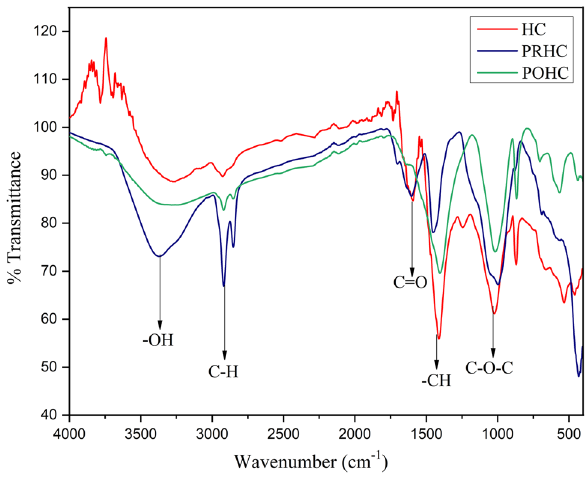
Figure 6. FTIR spectra of hydrochars.